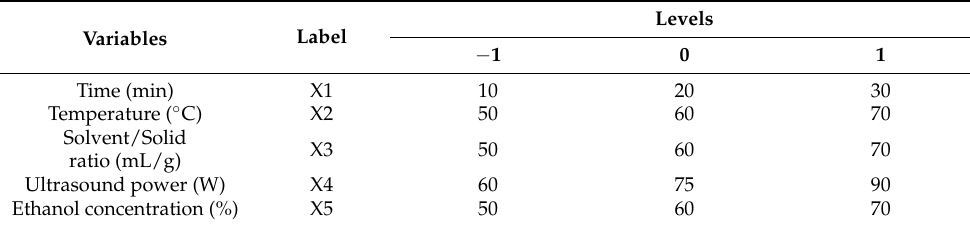
Table 1. Independent variables at three coded levels of variation for the Box–Behnken